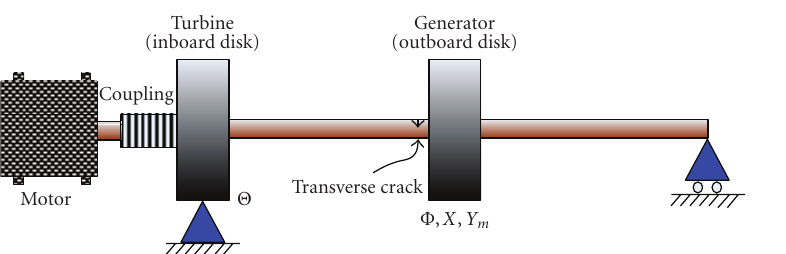
Figure 1: Configuration of the cracked extended Je ff cott rotor with two disks.